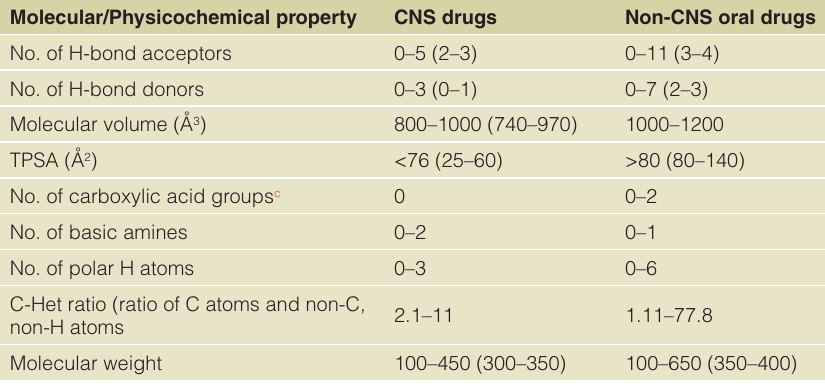
Table 1. Comparison between CNS and non-CNS drugs in terms of associated properties a,b